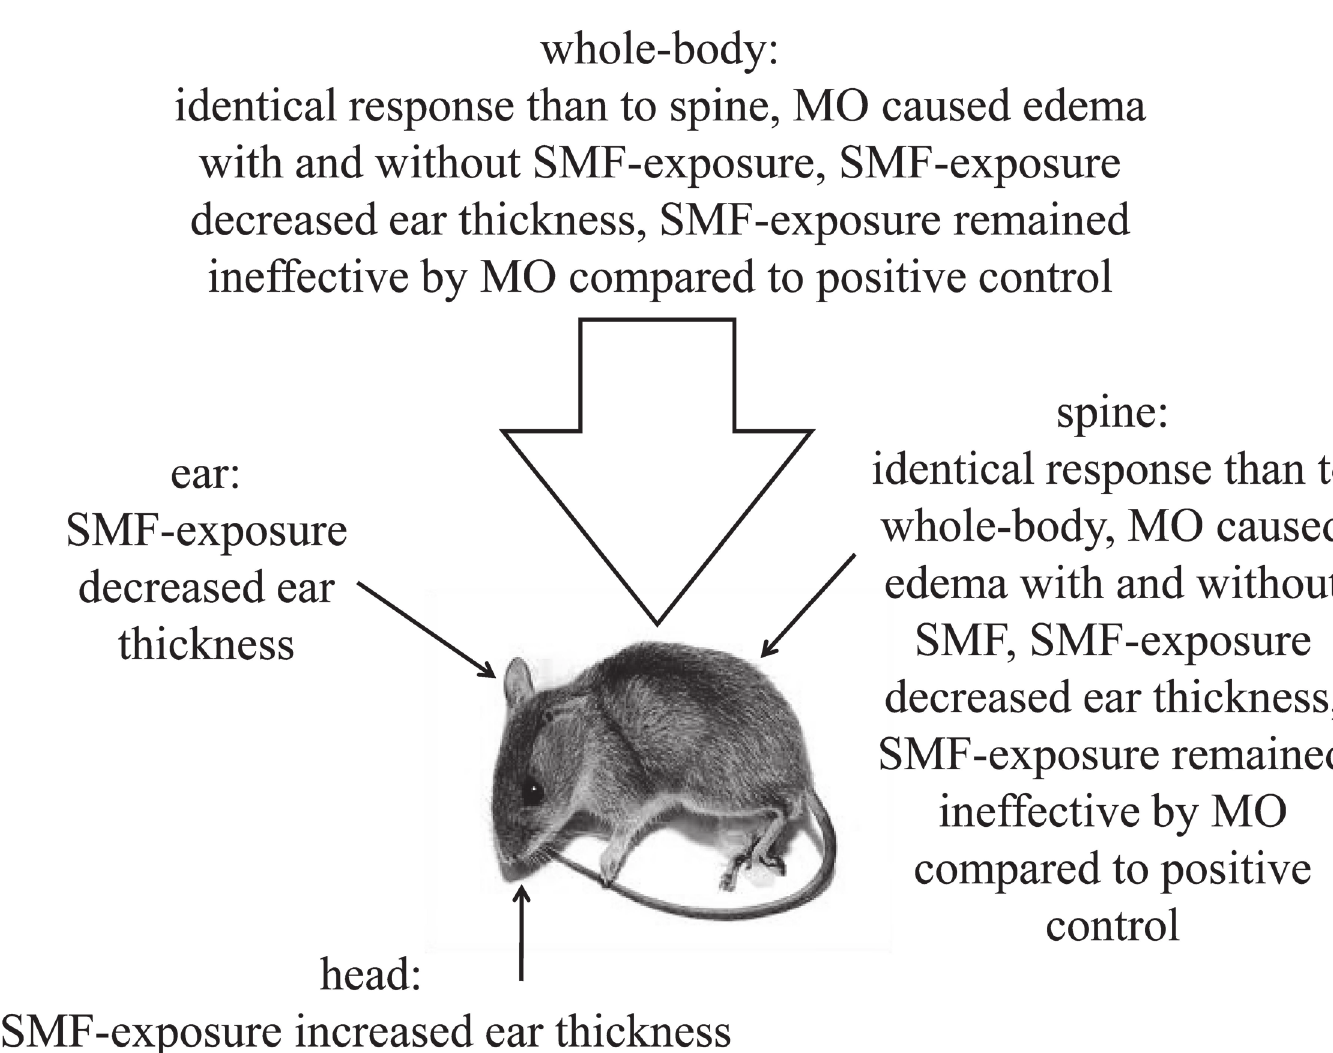
Fig 4. The observations in mice challenged with mustard oil (MO) in an induced ear edema model by different static magnetic field (SMF)- exposures: whole-body, local on the spine, local on the ear, and local on the